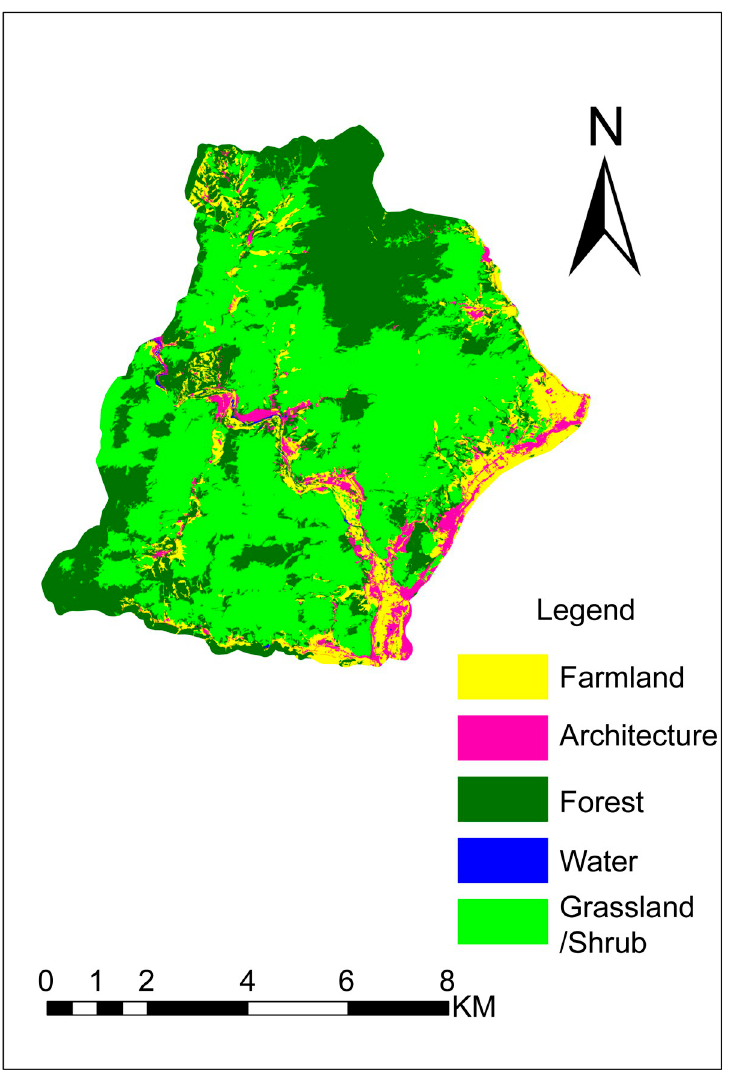
Fig 7. Object-oriented classification of Longmen Tianguan (Republished from [https://directory.eoportal.org/ web/eoportal/satellite-missions/g/gaofen-2] under a CC BY license, with permission from [Hebei Zhongke Sino Star Information Technology Co., Ltd], original copyright [2018]).